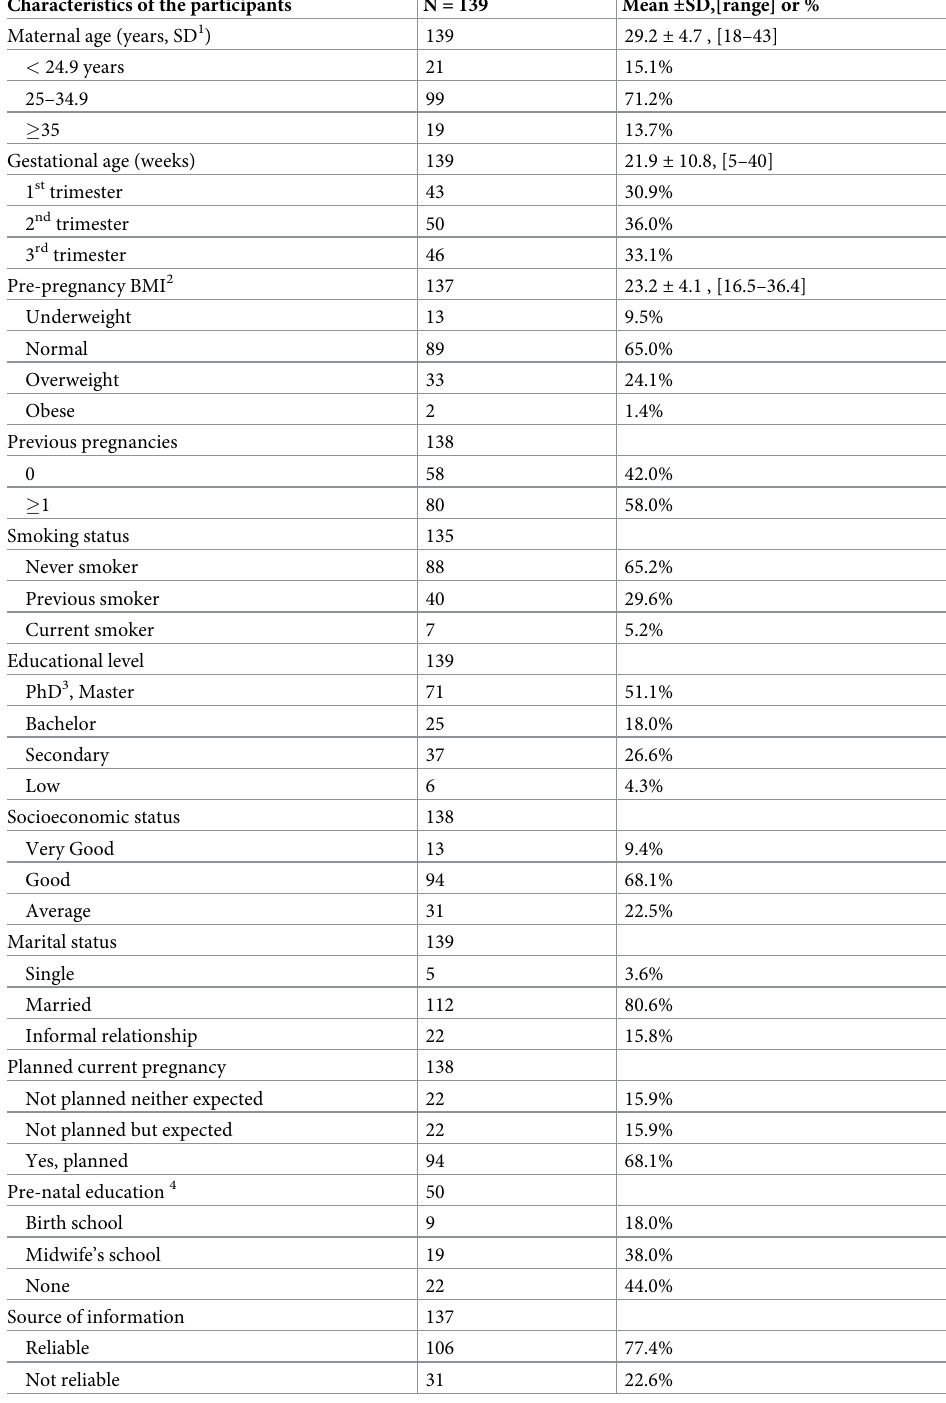
Table 1. Characteristics of the study